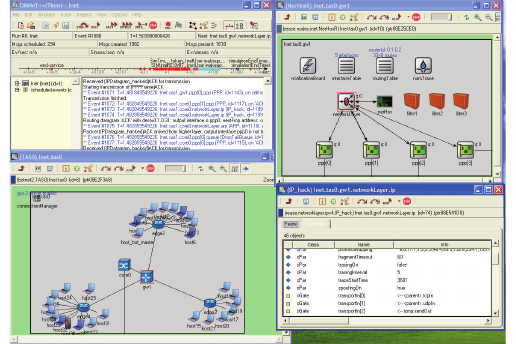
Figure 2: The interface of the simulation system.